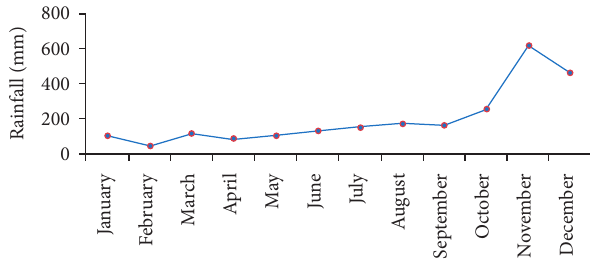
Figure 2: Mean monthly rainfall in the study area